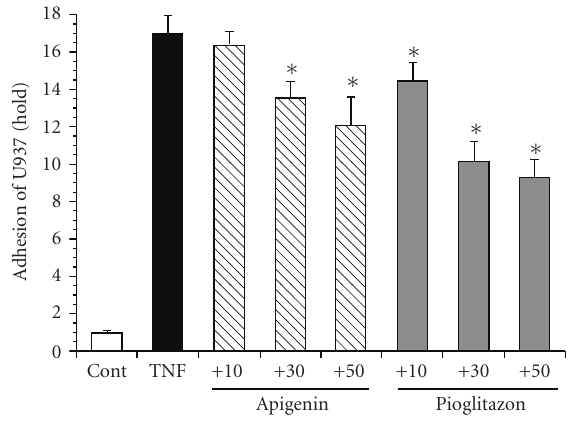
Figure 8: The inhibitory e ff ects of apigenin and pioglitazone on U937 cell adhesion in astrocytes isolated from SHRSP. The astrocytes isolated from SHRSP/IZM were cultured for 24 hours with or without 10, 30, or 50 μ M of apigenin or pioglitazone and were then challenged with TNF- α (10ng/mL). The U937 cells (1 × 10 6 cells/mL) were added and incubated with astrocytes at 37 ◦ C for 3 hours. The adhesion of U937 cells to the astrocytes was measured using quantitative monolayer adhesion assays, similar to those previously described [28]. The inhibitory e ff ects of apigenin are indicated (fold). The number of bound U937 cells per square millimeter was determined by direct microscopy. The data are means ± S.D ( n =